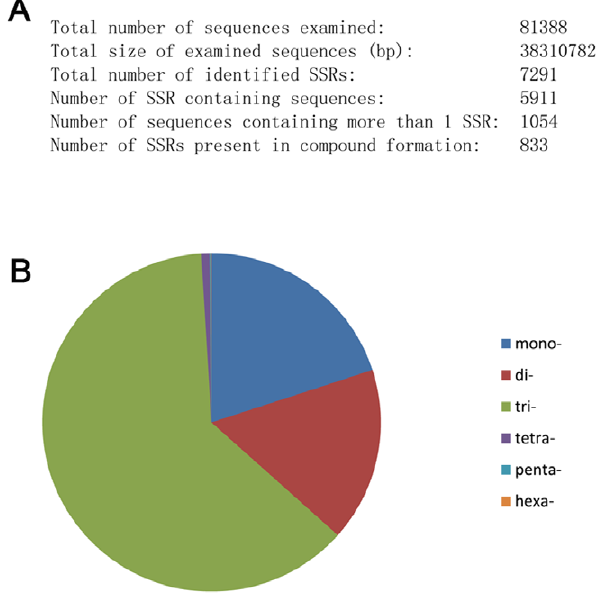
Figure 5. Frequency of microsatellite classes in the transcrip- tome of Sogatellafurcifera . (A) Summary of SSR analysis resulting from MISA software prediction. (B) The mono- to hexanucleotide microsatellite distributions in the transcriptome sequence of S. furcifera .